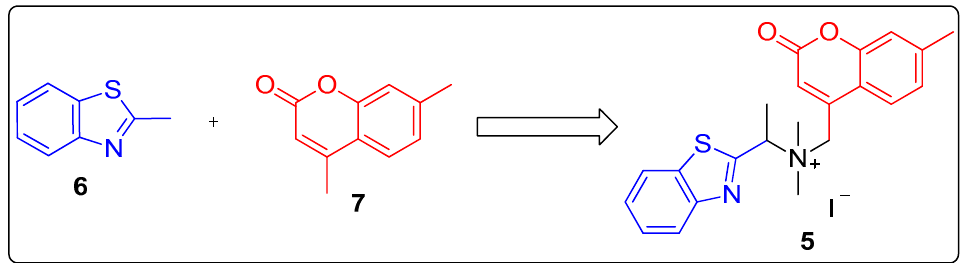
Figure 2. Design strategy of probe 5.